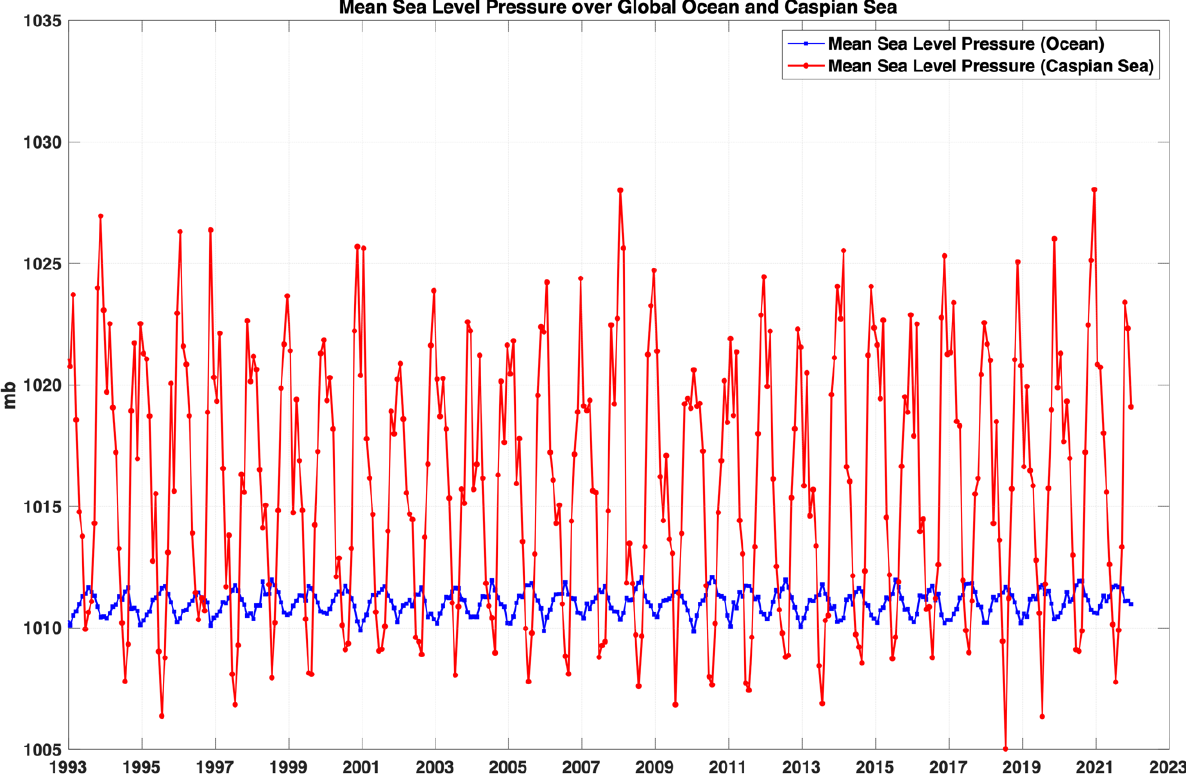
Figure 4. Monthly mean sea level pressure (in units of mb) over the global ocean (blue curve) and Caspian Sea (red curve) over the period January 1993 to December 2021, estimated from the ECMWF ERA5 mean sea level pressure data.